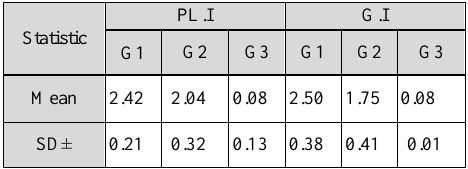
Table (1): Descriptive statistics (mean ±SD) of plaque and gingival index in each group.